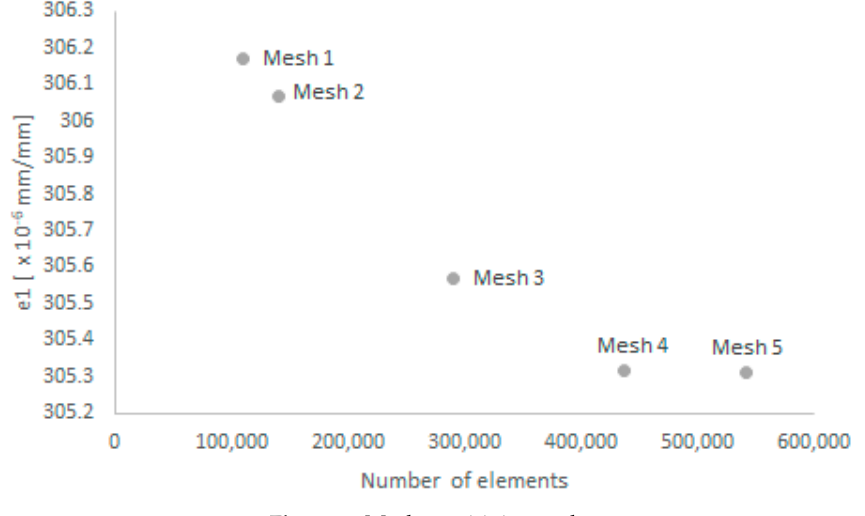
Figure 8. Mesh sensitivity study.